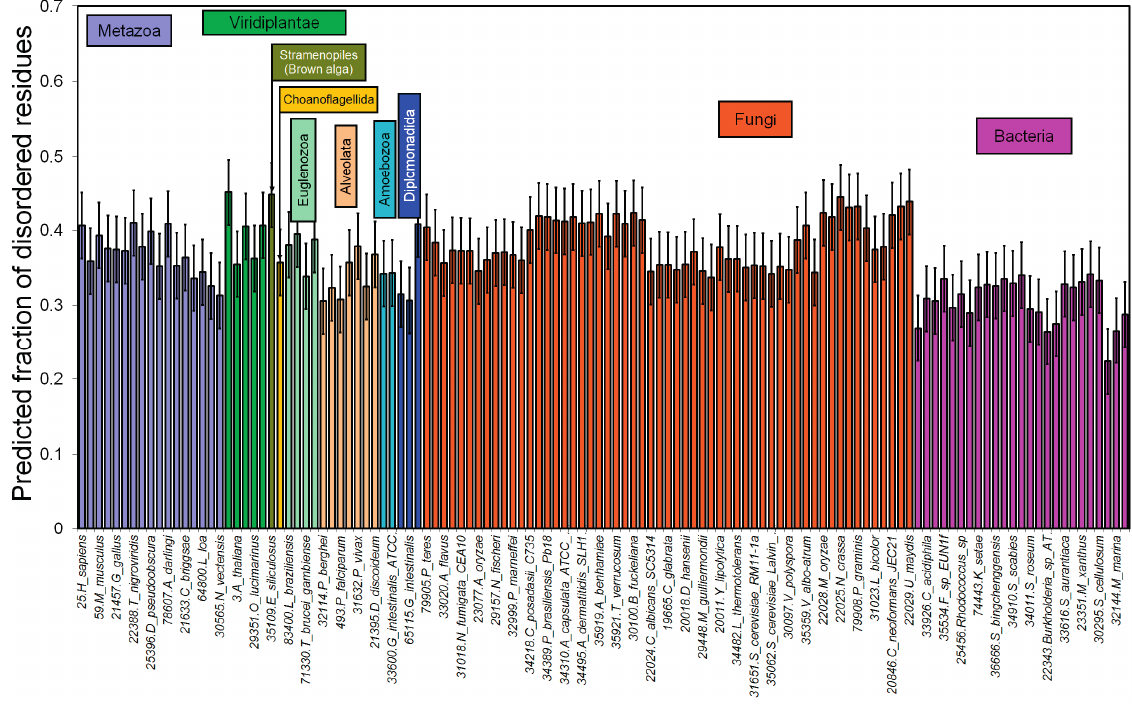
Figure 4. Predicted fraction of disordered residues for 122 proteomes. Error bars are standard